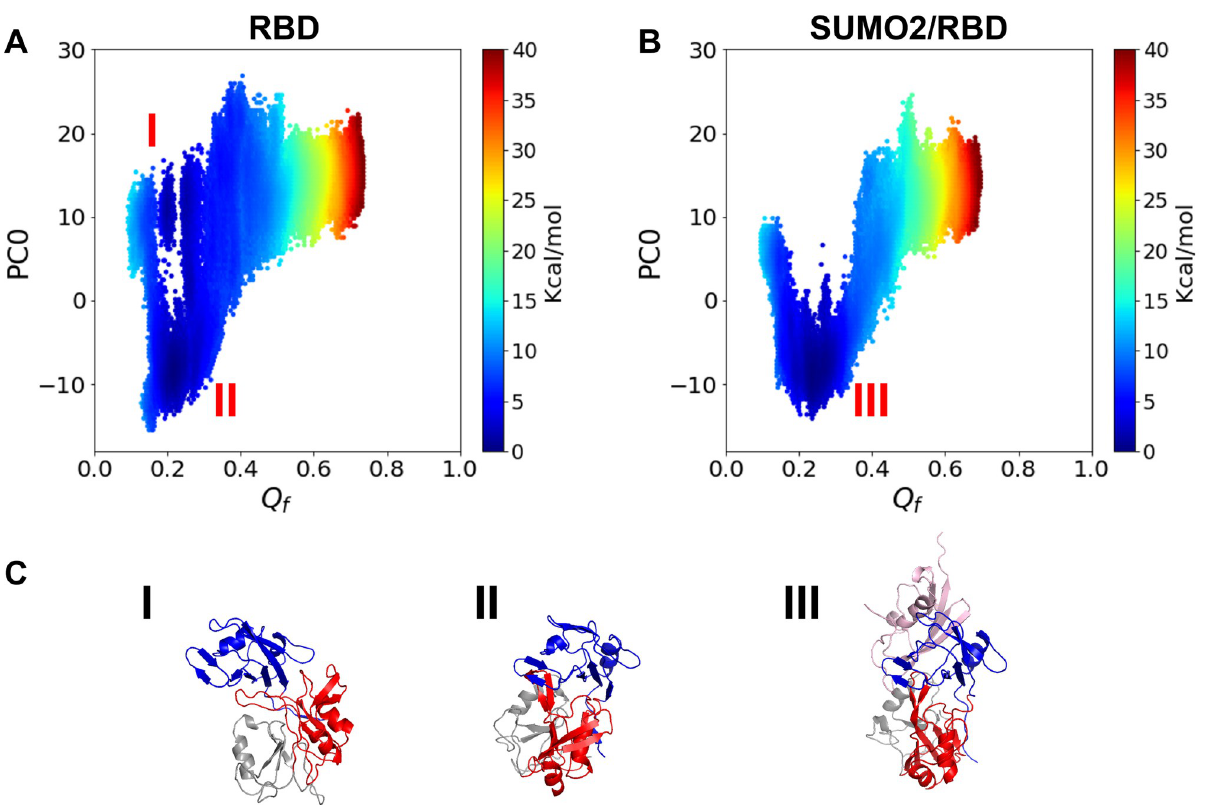
Fig 5. A . The free energy landscape for RBD plotted using Q f and PC0 as the two order parameters. Q f is the structural similarity metric to the NMR structure of free RRMs considering inter-domain residue pairs between RRM1 and RRM2 only. B . The free energy landscape for the SUMO2/RBD complex plotted using Q f and PC0 as the two order parameters. C . Representative structures for the three free energy basins in Fig 5A and 5B.